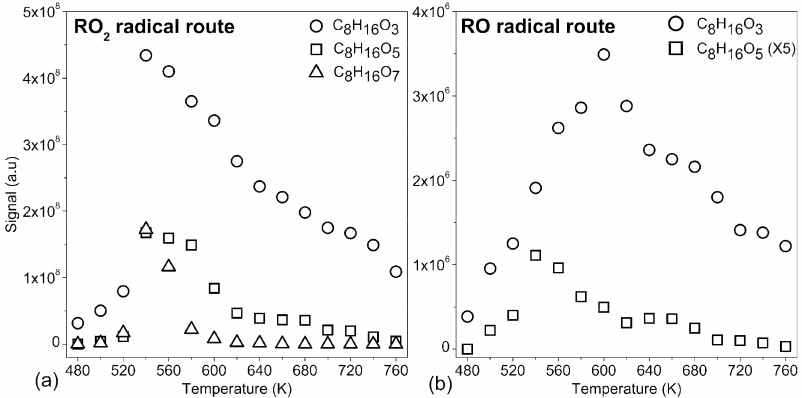
Figure 6. Experimental UHPLC-HRMS signal profiles of C 8 H 16 O 3,5,7 formed during the low-temperature oxidation of DBE. ( a ) Species formed in combustion: unsaturated DBE- yl-hydroperoxides (C 8 H 16 O 3 ), unsaturated DBE-yl-di-hydroperoxides (C 8 H 16 O 5 ), and unsat- urated DBE-yl-tri-hydroperoxides (C 8 H 16 O 7 ) and carbonyls, i.e., (HOO) 2 (HO)(O=)C 8 H 13 O. ( b ) Species formed in the atmospheric RO • oxidation route: O=C 8 H 15 O(HO) (C 8 H 16 O 3 ) and